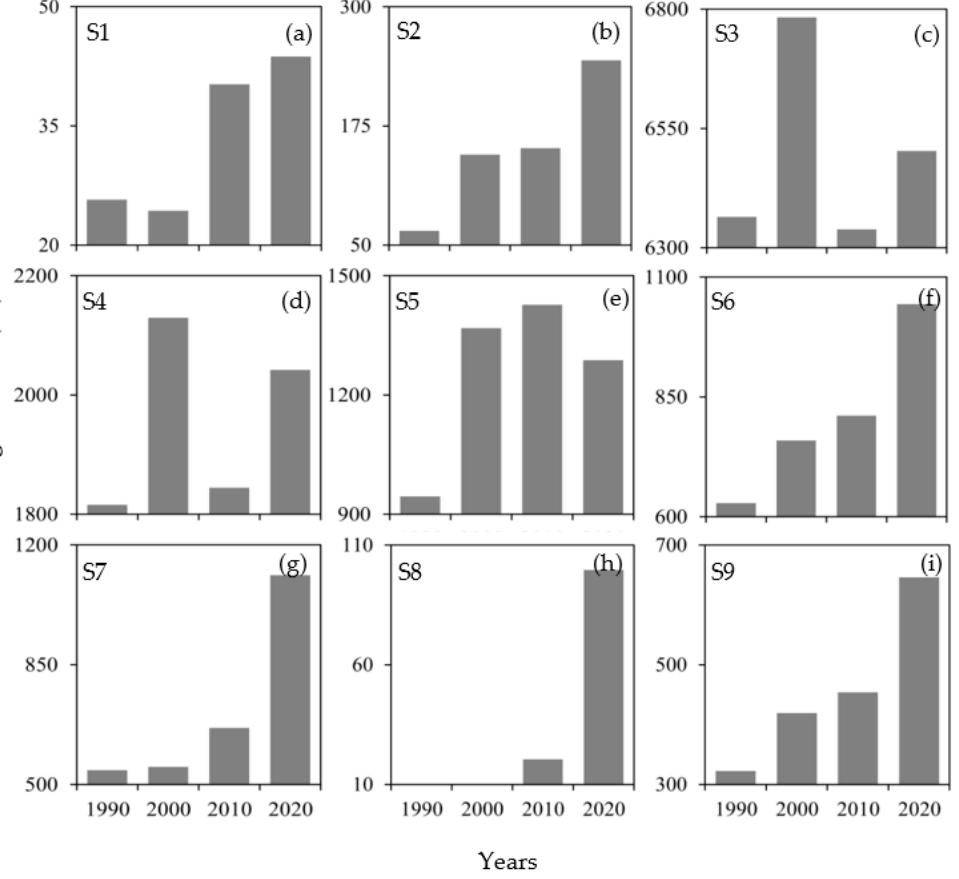
Figure 5. Mangrove forest dynamics over time (from 1990 to 2020) within each mangrove site (S1–S9 in Figure 1) on SMRI images presented in separated panels ( a – i ).